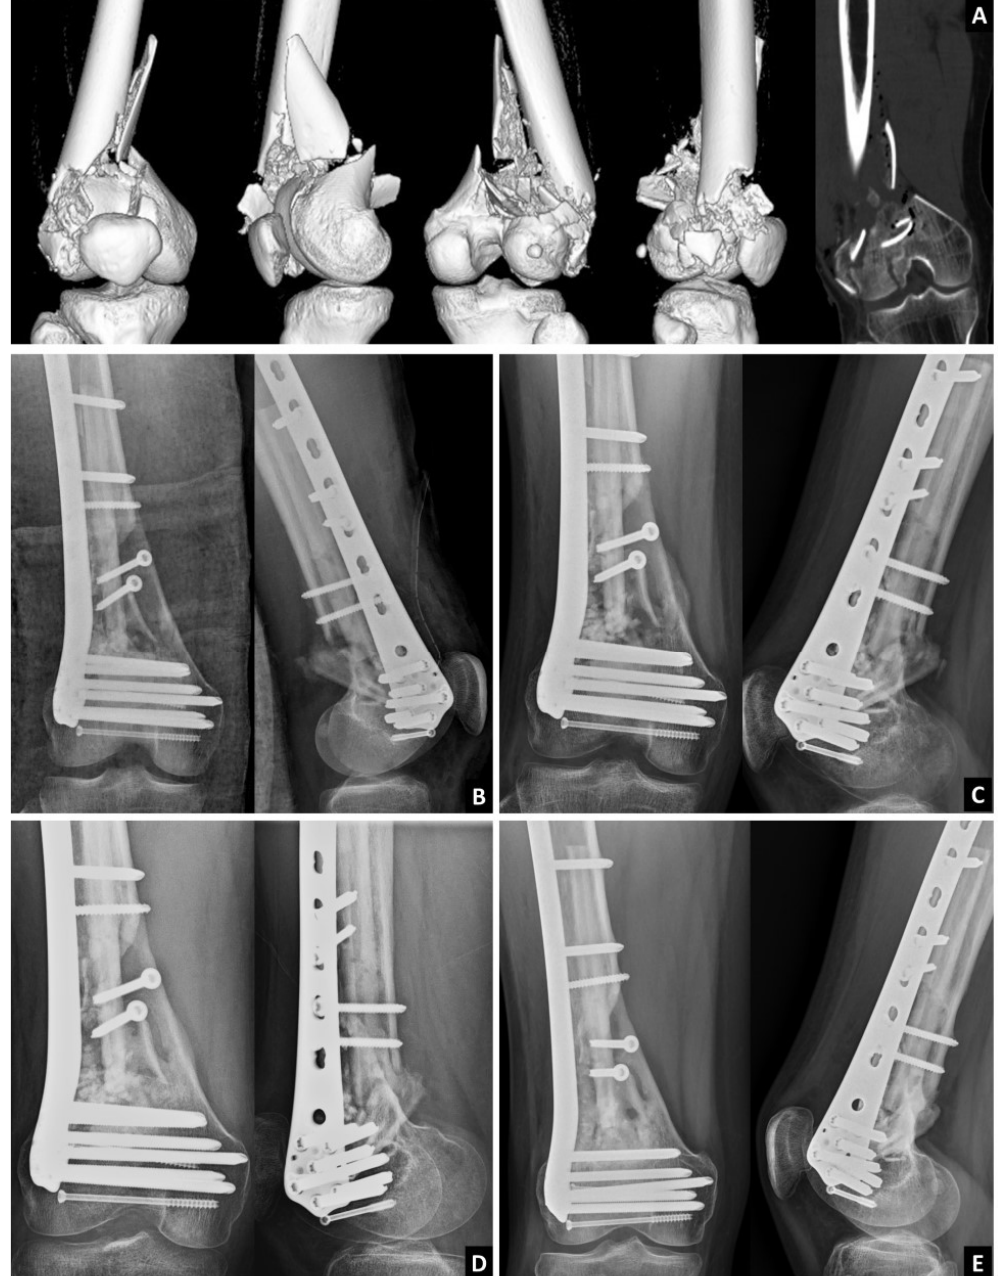
Figure 4. A 19-year-old male patient was involved in a traffic accident. Distal femoral open fracture with a 4 cm open wound at the anterolateral side of the distal femur. Computed tomography showed a severe comminuted metaphysis, AO 33-C2. After adequate debridement and irrigation, an allogenic fibular strut was applied. Medial cortex was fixed on the fibular strut. Allogenic TKA bone chip was stuff in the bone defect. ( A ) CT; ( B ) Post-OP; ( C ) Post-OP 3 months; ( D ) Post-OP 6 months; ( E ) Post-OP 1 year.